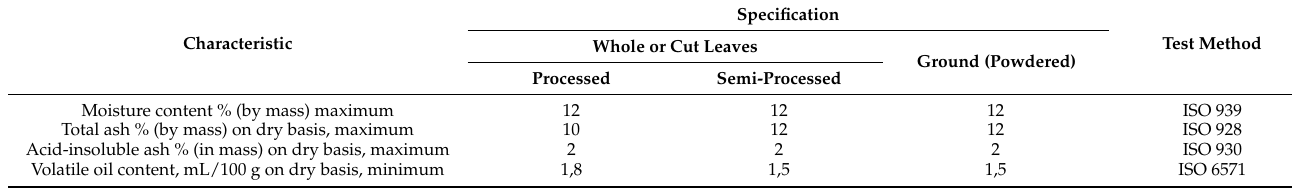
Table 2. ISO Chemical Requirements for dried oregano